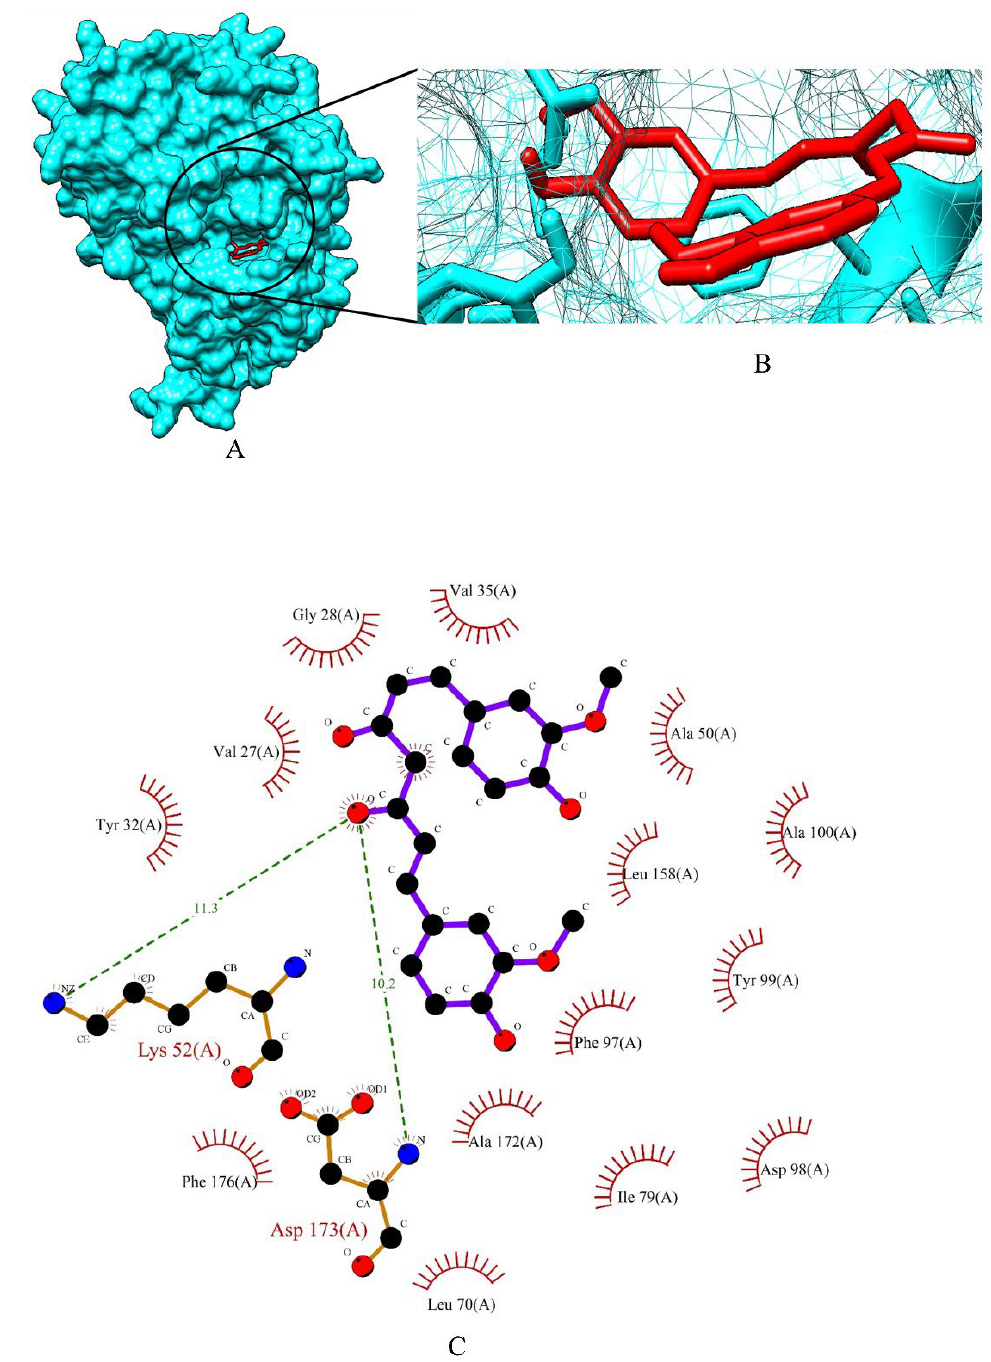
Figure 4. ( A ) Surface view of curcumin-CDK8 binding complex. ( B ) Binding pose of curcumin. ( C ) Visualization of the docked complex with ligplot + shows the binding interaction of curcumin with CDK8. Two hydrogen bond interactions (green dotted lines) were formed between curcumin and two amino acid residues (Lys 52, Asp 137) of target protein CDK8.